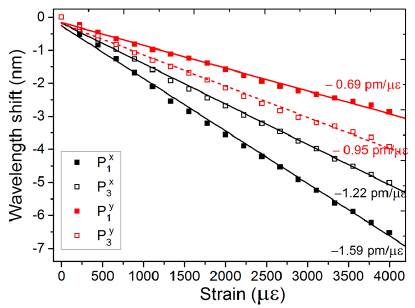
Figure 6. Strain response of the fiber m-MZI using highly birefringent ATC-PCF ( L ~ 5.1 cm).